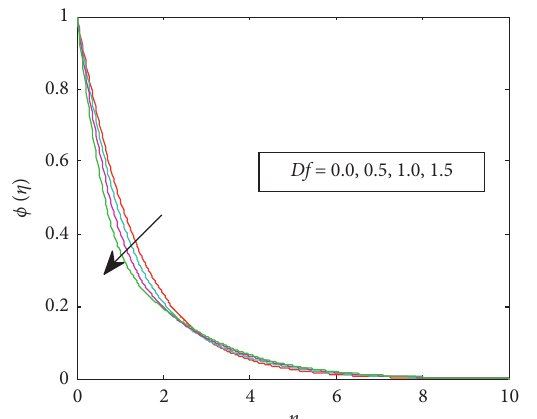
Figure 6: Concentration distribution for different values of Dufour parameter.